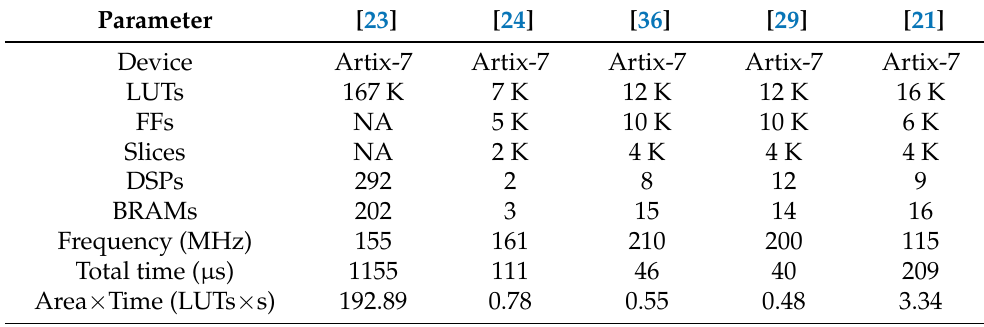
Table 6. Comparison of the state-of-the-art Kyber-768 hardware architectures.